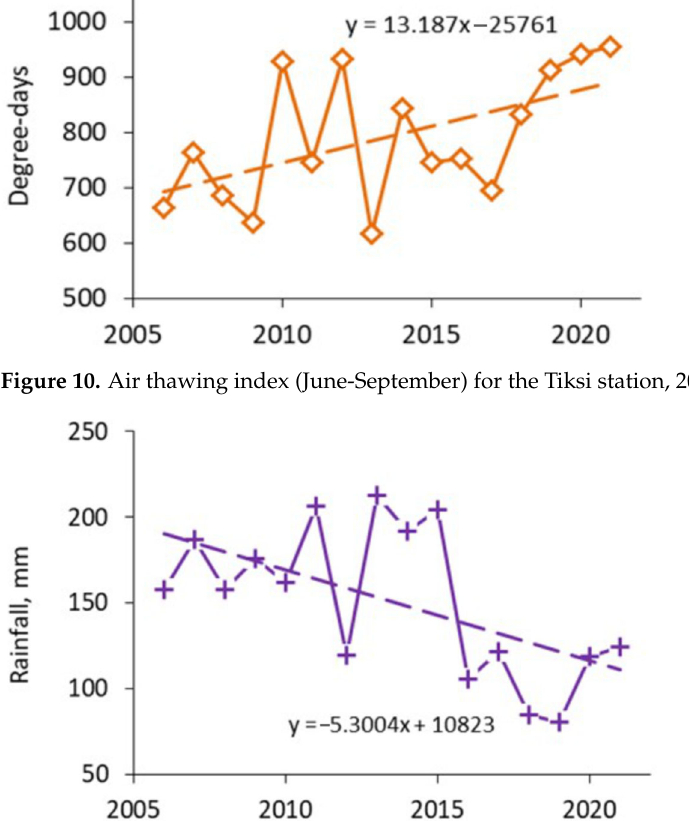
Figure 11. Rainfall amounts for the Tiksi station, 2005–2022.